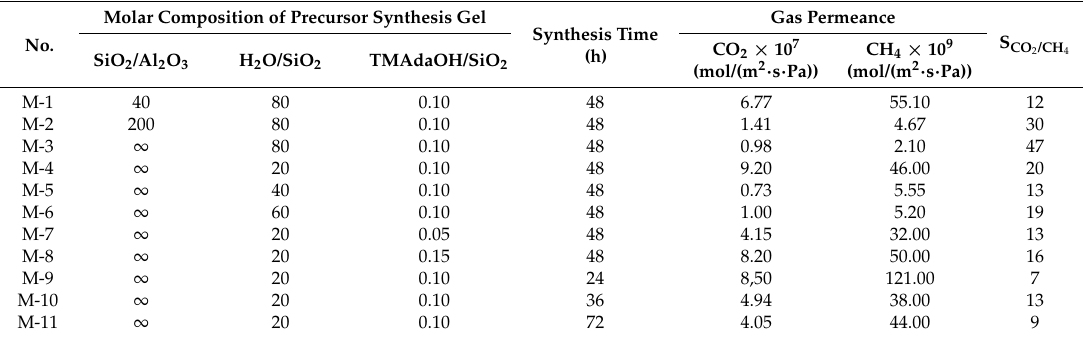
Table 1. Effects of molar composition of precursor synthesis gel and synthesis time on single gas permeance and ideal selectivity of SSZ-13 zeolite membranes (25 ◦ C, 0.4 MPa).